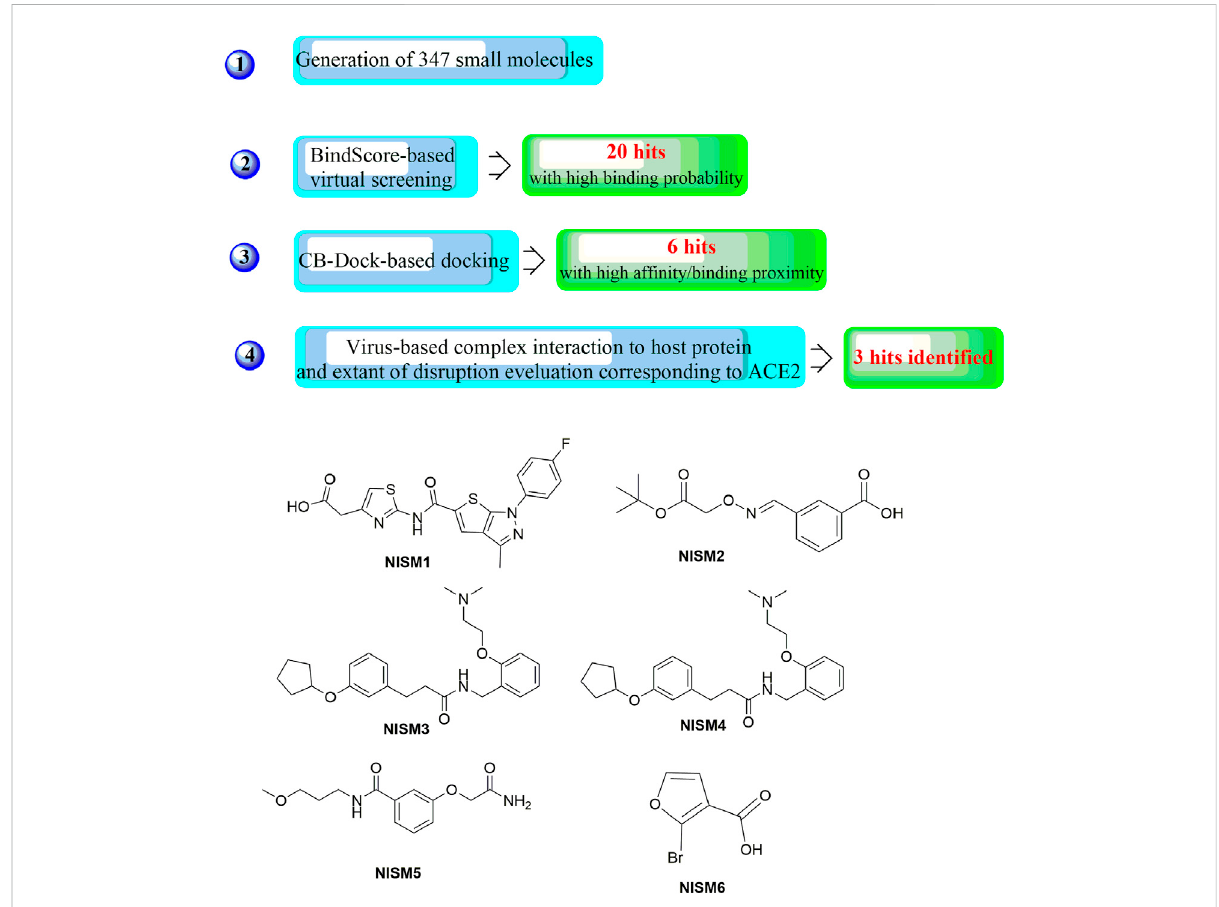
FIGURE 13 Strategies for the further structural optimization of arbidol (A) , dolutegravir and bictegravir (B) and the structures of BD-2, Ti-2 and